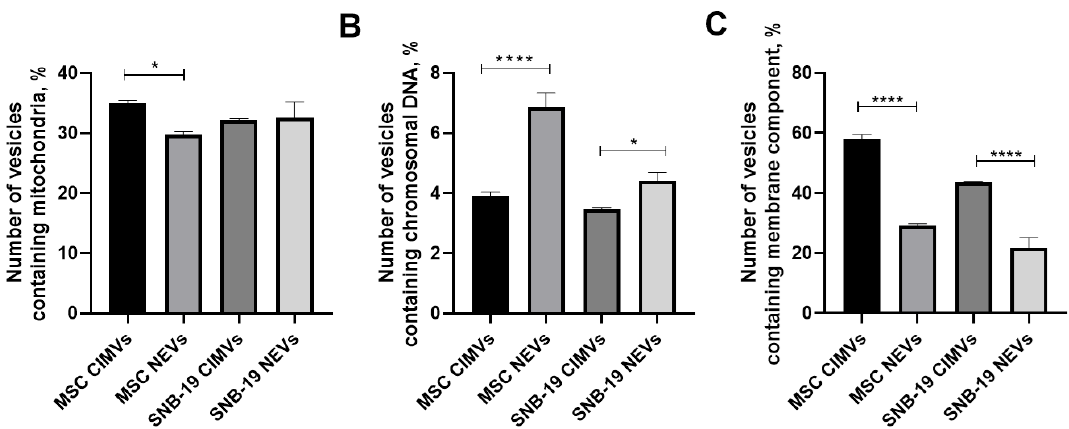
Figure 6. ( A ) Analysis of the presence of the mitochondrial component in CIMVs and NEVs. ( B ) Analysis of the presence of a nuclear component in CIMVs and NEVs. ( C ) Percentage of CIMVs and NEVs stained with membrane dye. Data are shown as the mean percentage ± SD (n = 6) of two biological replicates. * p < 0.05, **** p < 0.0001.